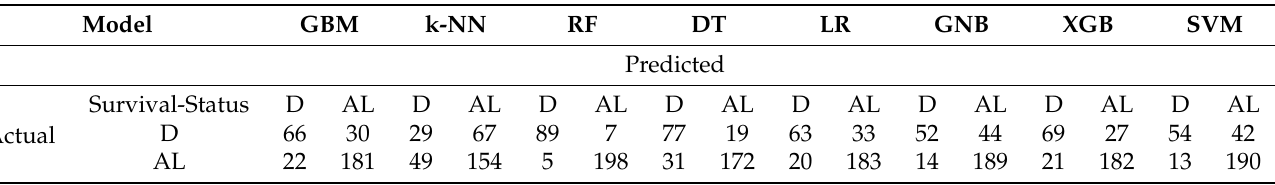
Table 18 represents all the CMs of survival-status classification algorithms. Here, TP (second row) represents the total number of right-predicted alive patients, and TN (first Row) represents the total number of right-predicted dead patients. Among all specified CMs, the RF classifiers’ CM displayed notable results with the highest Dead (89) and Alive (198). Only seven dead patients were wrongly predicted as alive and only 5 alive patients misclassified as dead by RF classifier compared to other classifiers. The k-NN algorithm has made the highest misclassification in the prediction of alive (49) and in dead (67). Table 18. Survival Status classifier’s CMs.